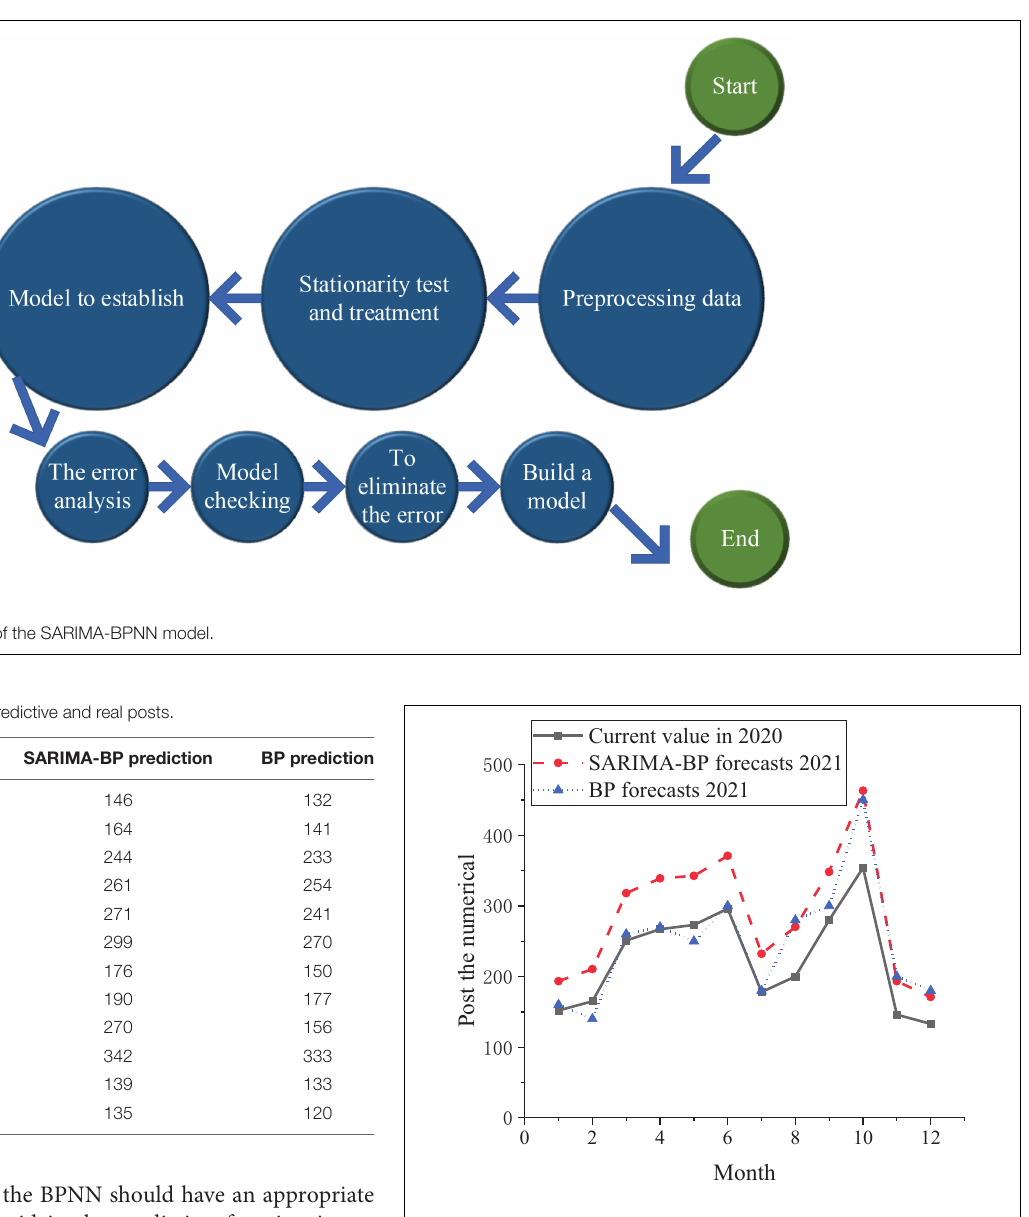
FIGURE 7 | Prediction trend of job demand in